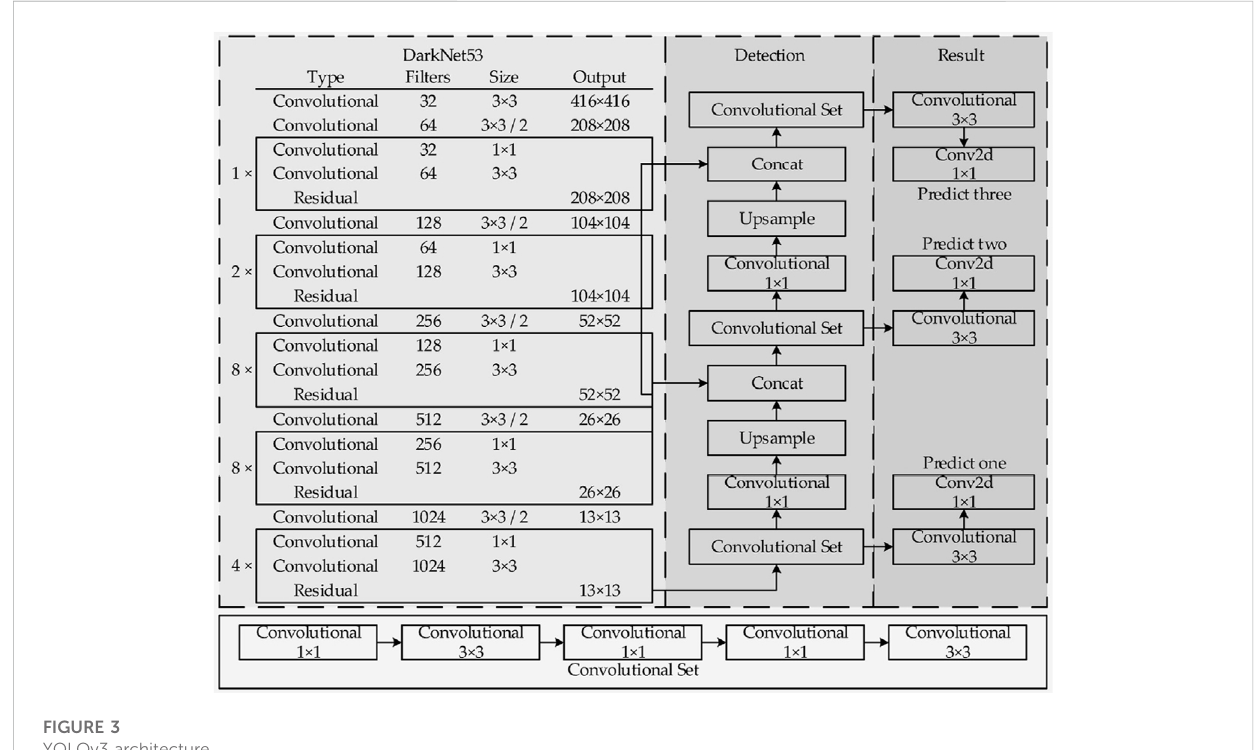
FIGURE 3 YOLOv3 architecture.